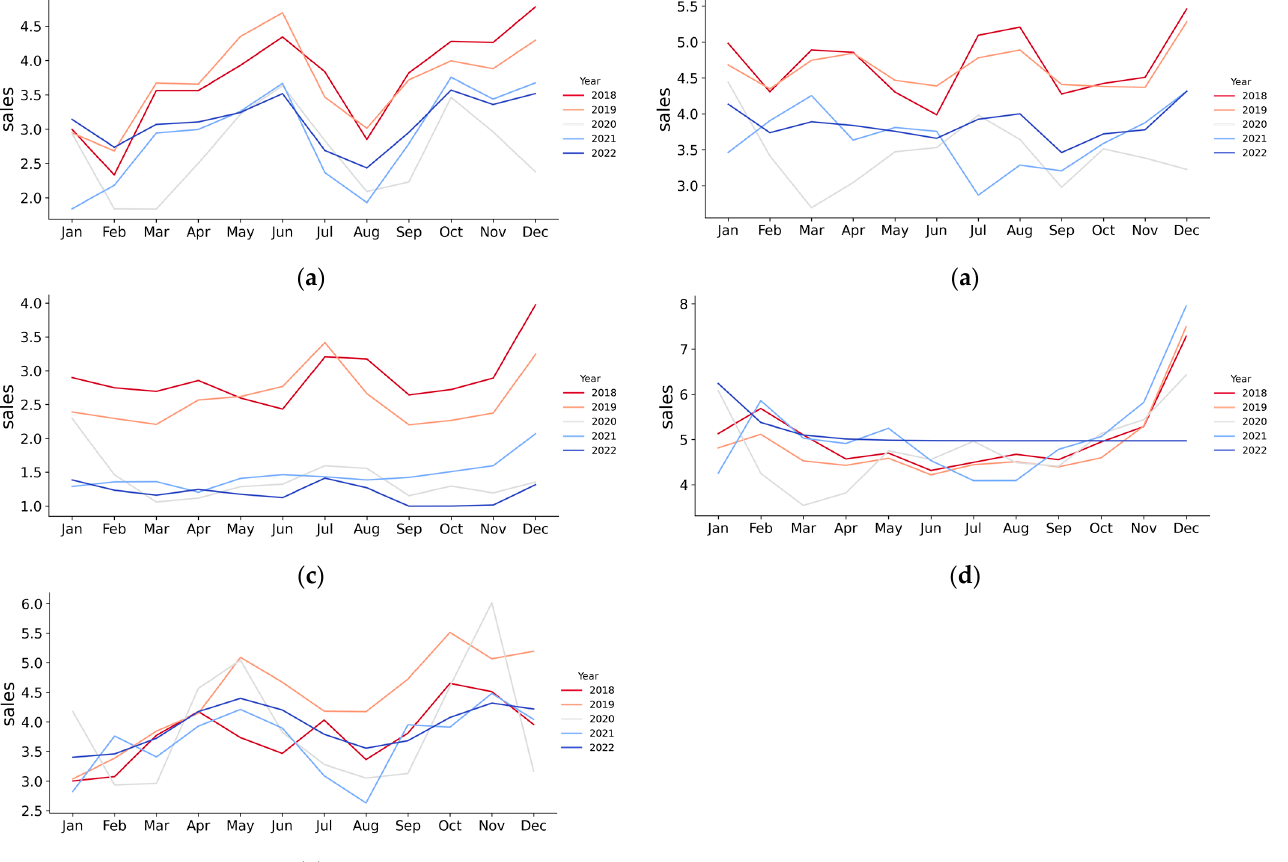
Figure 4. Annual sales in each retail category including precited 2022 sales. ( a ) Fashion; ( b ) f&b; ( c ) entertainment; ( d ) cosmetics; ( e ) sport. Annual sales graphs—2018 (red) and 2019 (orange) sales graphs are pre-COVID-19, 2020 (gray) is when COVID-19 occurred and 2021 (sky blue) and 2022 are projected sales (light blue) after the COVID-19 outbreak—provide an overview of the impact of the COVID-19 pandemic and the degree of recovery. It was confirmed that fashion sales were notably impacted, based on the graph from 2020, and would show a recovery trend over time, implying that, in 2022, they would have recovered to a level similar to that before the COVID-19 outbreak. The f&b sales were also impacted by the COVID-19 outbreak and recovered over time. However, it was confirmed that there would be difficulty in recovering the sales to the level before the outbreak. This is assumed to be because f&b stores were directly af- fected by social distancing policies, such as limiting the number of people in a store. Furthermore, entertainment sales were hit hard by the COVID-19 outbreak, with sales falling over time. This seems to reflect the impact on movie theaters, which account for a large proportion of the entertainment category. Postponement or cancellation of the release of many movies due to COVID-19 are held up as causes of the harm to the sales category. Cosmetics and sport sales showed similar characteristics to one another. In both, the COVID-19 outbreak’s impact was not significant, and sales showed a stable pattern each year. Similar sales were forecasted to be recorded by 2022 to those pre-COVID-19.